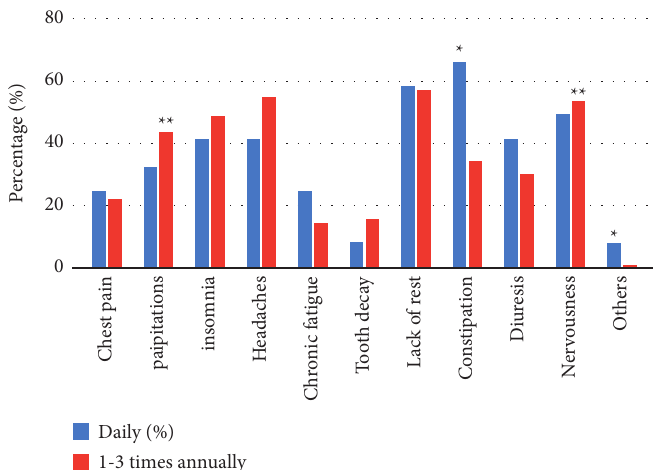
Figure 3: Analysis of side effects experienced by daily energy drink consumers versus 1–3